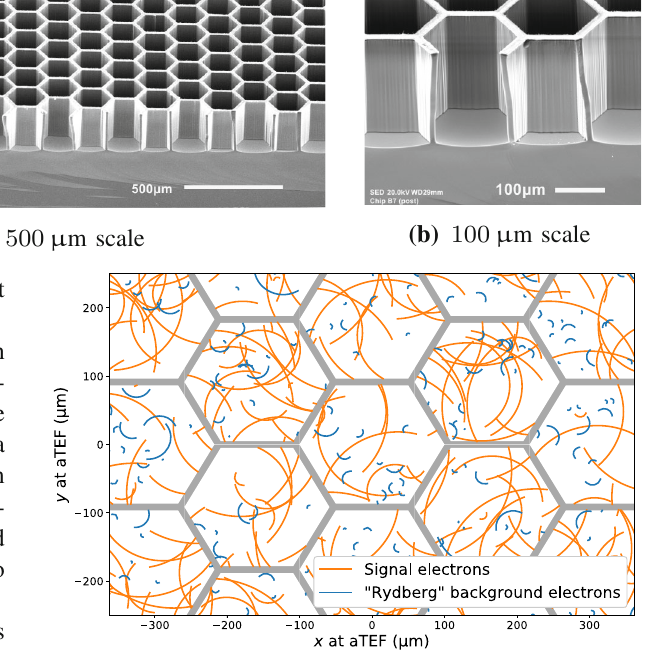
Fig. 7 Simulation of signal (orange) and background (blue) electron tracksina2.4Taxialmagneticfieldwiththeangulardistributionsshown in Fig. 1 for a honeycomb-like aTEF structure with an side length of 100 µ m,awallthicknessof10 µ m,andadepthof400 µ m.Thetracking of an electron is stopped, when it either hits the aTEF surface or when it reaches the full depth without any